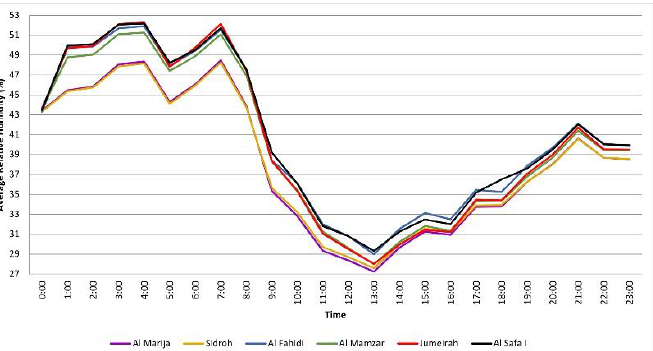
Figure 12. Hourly variations of wind speeds (m/s) for Al Marija, Sidroh, Al Fahidi, Al Mamzar, Jumeirah, and Al Safa I in December.